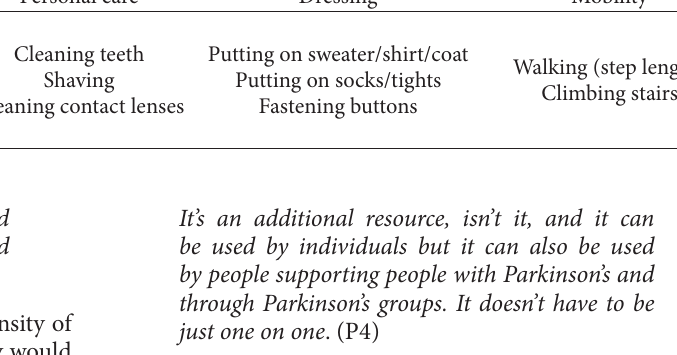
Putting on sweater/shirt/coat Putting on socks/tights